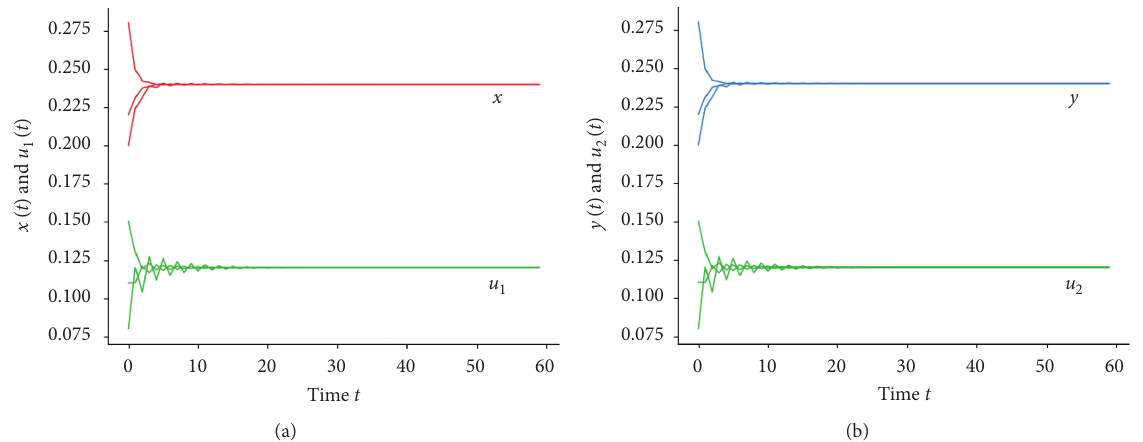
Figure 1: Dynamic behaviors of system (29) with the initial conditions (0.28, 0.28, 0.08, 0.08), (0.22, 0.22, 0.11, 0.11), and (0.20.0.20, 0.08, 0.08) when r � 2 . 1 ,a � 2 .b � 1 , e � 1 , η � 2 , and D � 1 . 5.